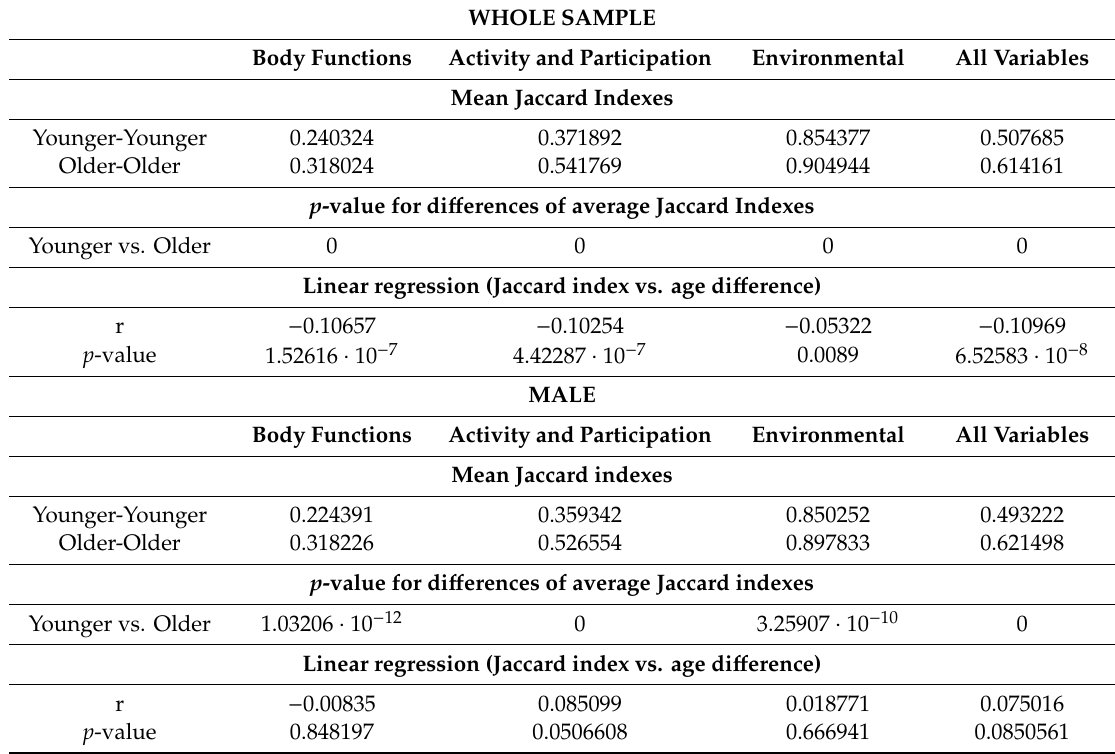
Table 4. Analysis of